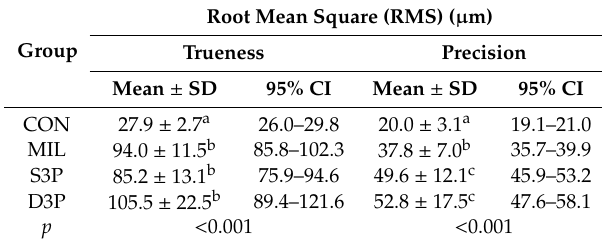
Table 1. The accuracy (trueness and precision) of four groups for full arch.